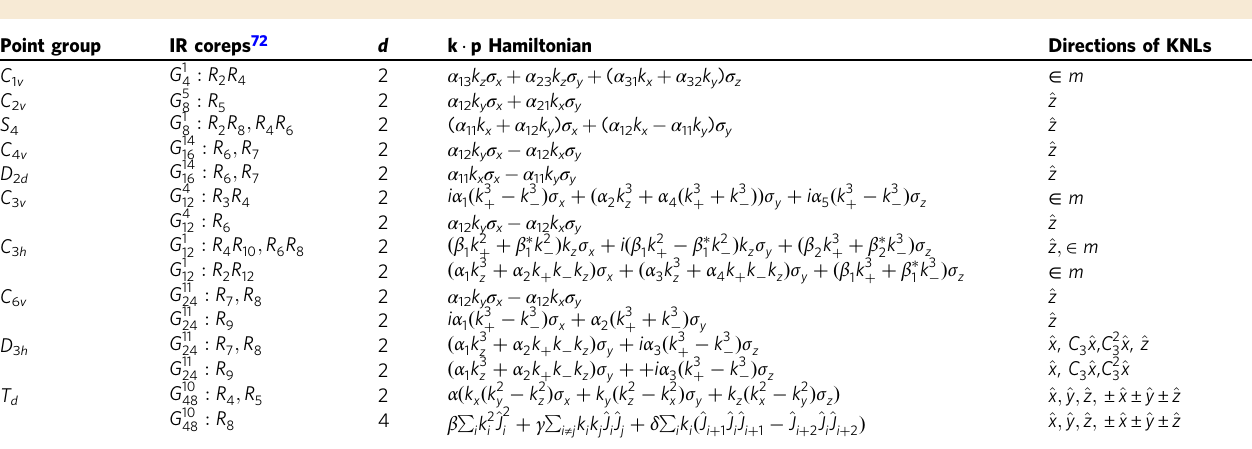
Table 2 The k ⋅ p Hamiltonians at TRIMs with non-centrosymmetric achiral little groups. Point